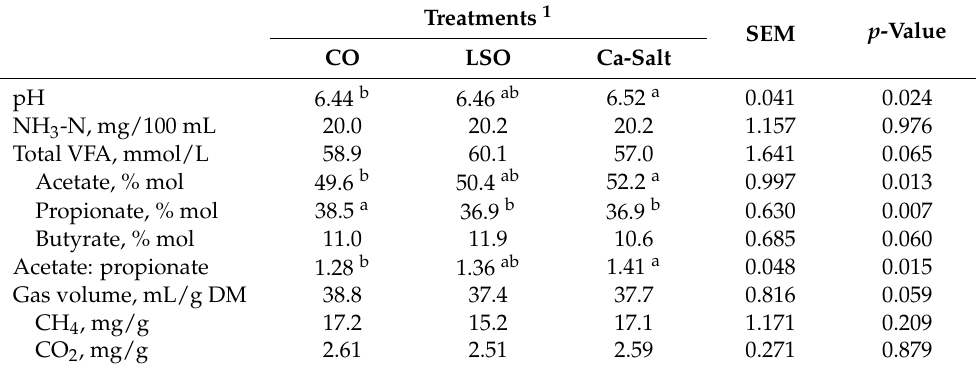
Table 4. Effects of oil source supplementation containing essential fatty acid on rumen fermentation characteristics and greenhouse gas emissions of rumen buffer after 24 h of